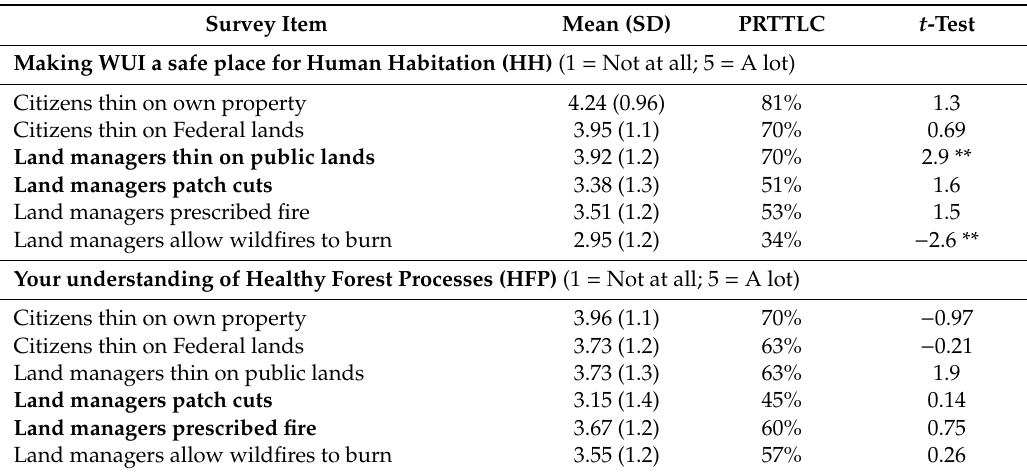
Table 5. Forest and fuel management practices: how do the following practices support ...